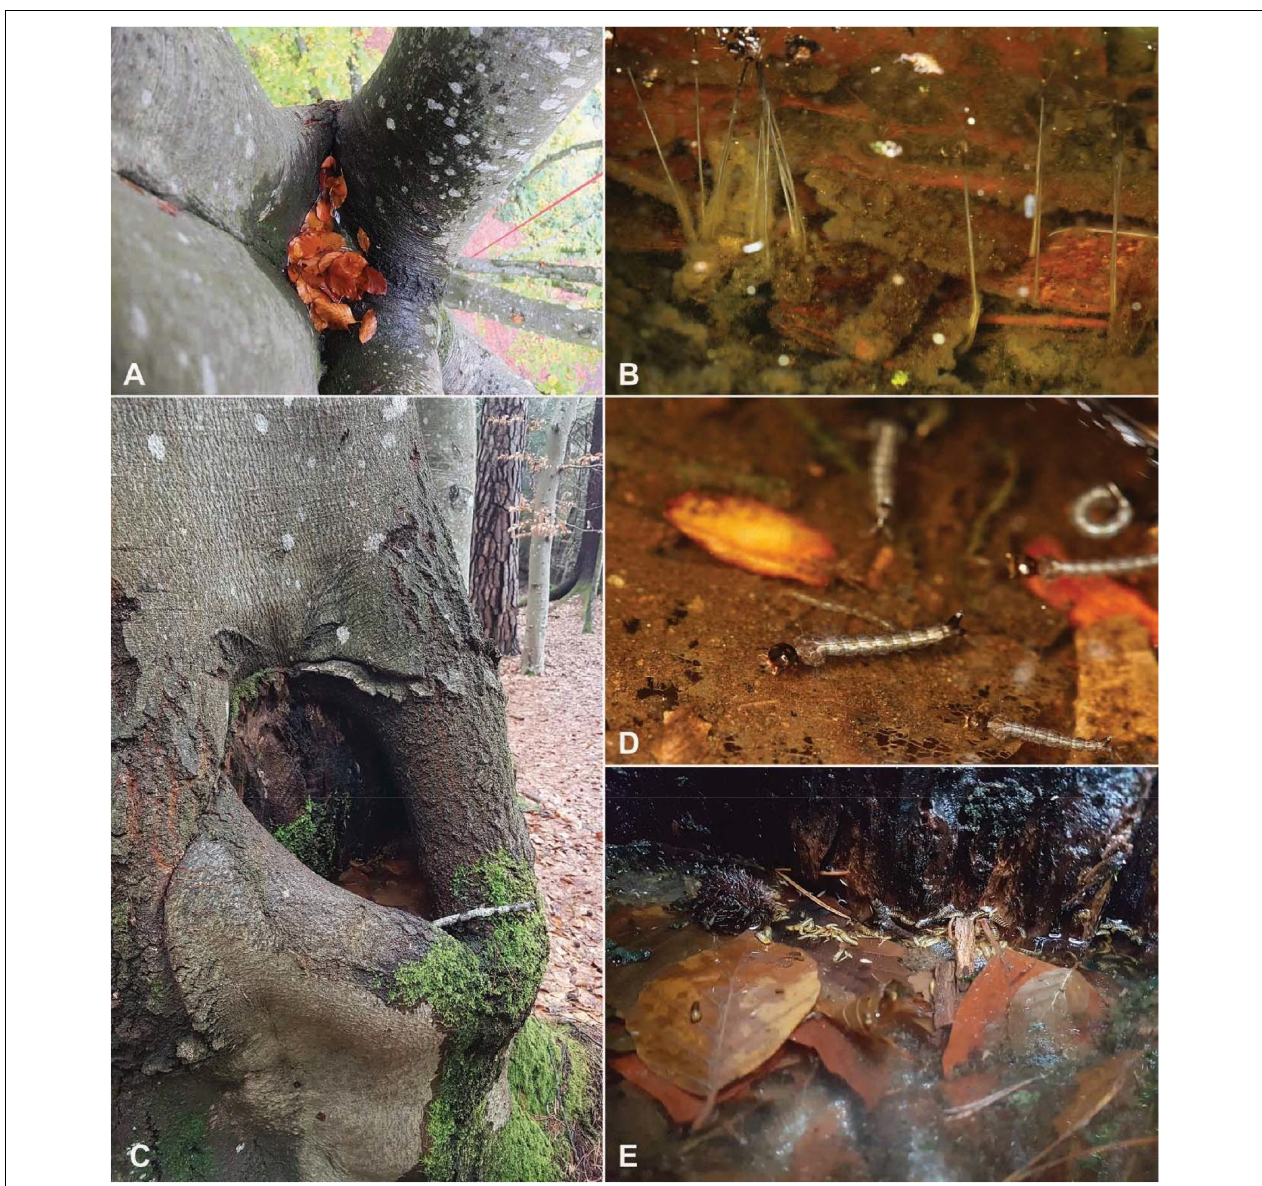
FIGURE 6 | (A) Water-filled tree hole in a branch fork of a beech tree at 20 m height. At this height these microcosms receive considerable leaf litter input, resulting in a large amount of detritus relative to the tree-hole volume. (B) The abundance of the hoverfly Myiatropa florea (Diptera: Syrphidae) increases with tree-hole height. These rat-tailed maggots are characterized by a long, tube-like, telescoping breathing siphon that acts like a snorkel, allowing the larvae to breathe air while submerged. (C) Near ground level, very large water-filled tree holes with a volume > 10 l are sometimes found. (D) The larvae of the mosquito Aedes geniculatus (Diptera: Culicidae) prefers holes with wide openings near ground level. Larvae breathe atmospheric air through a siphon and filter algae, bacteria, and other microbes from the surface microlayer. (E) The beetle Prionocyphon serricornis (Coleoptera: Scirtidae) depends on large holes that do not dry out frequently. They survive freezing of the water in tree holes (most of the water column in the photo is frozen) by staying in bark crevices at the upper water level and become active as soon as the top layer